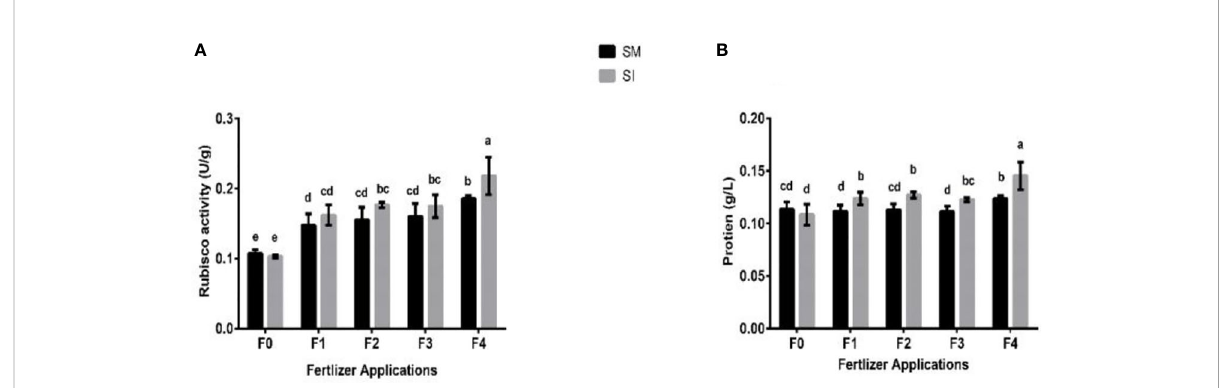
FIGURE 5 Rubisco activity (A) and soluble protein (B) of soybean crop under different planting patterns such as SM; soybean mono-cropping, SI; soybean intercropping and fertilizer application treatments such as F0 ; without fertilizer application, F1 ; nitrogen fertilizer application, F2 ; nitrogen fertilizer with foliar application of iron, F3 ; nitrogen fertilizer with foliar application of molybdenum, F4 ; nitrogen fertilizer with foliar application of iron and molybdenum. The column bars with dissimilar lowercase letters are signi fi cantly different from each other as per the LSD test (p< 0.05).